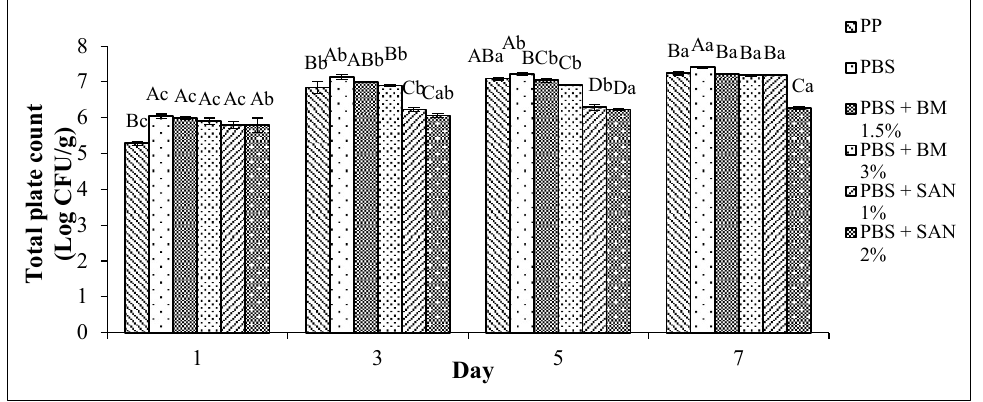
Figure 1. Total plate count (TPC) of chicken breast fillets stored in PP container and PBS film laminated tray during storage at 4 °C for seven days. Note: PP: polypropylene microwavable container (control); PBS: PBS film (untreated); PBS + BM 1.5%: PBS film + 1.5% Biomaster silver; PBS + BM 3%: PBS film + 3% Biomaster silver; PBS + SAN 1%: PBS film + 1% SANAFOR; PBS + SAN 2%: PBS film + 2% SANAFOR. Error bars indicate standard deviation (n = 3). The different A–D capital letters are significantly different ( p < 0.05) among treatment for each day. The different a–c lowercase letters are significantly different ( p < 0.05) among storage day for each sample.